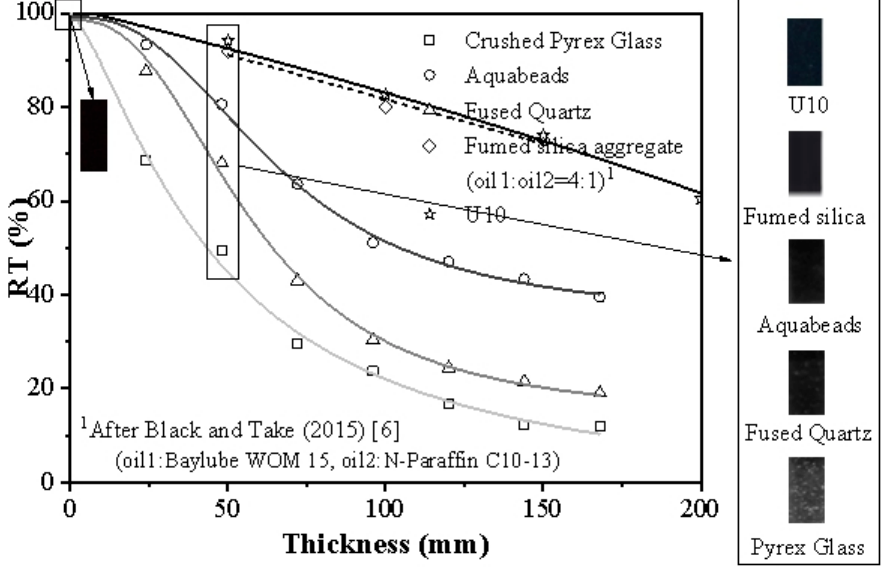
Figure 5. Transparency of materials versus soil thickness by the RT